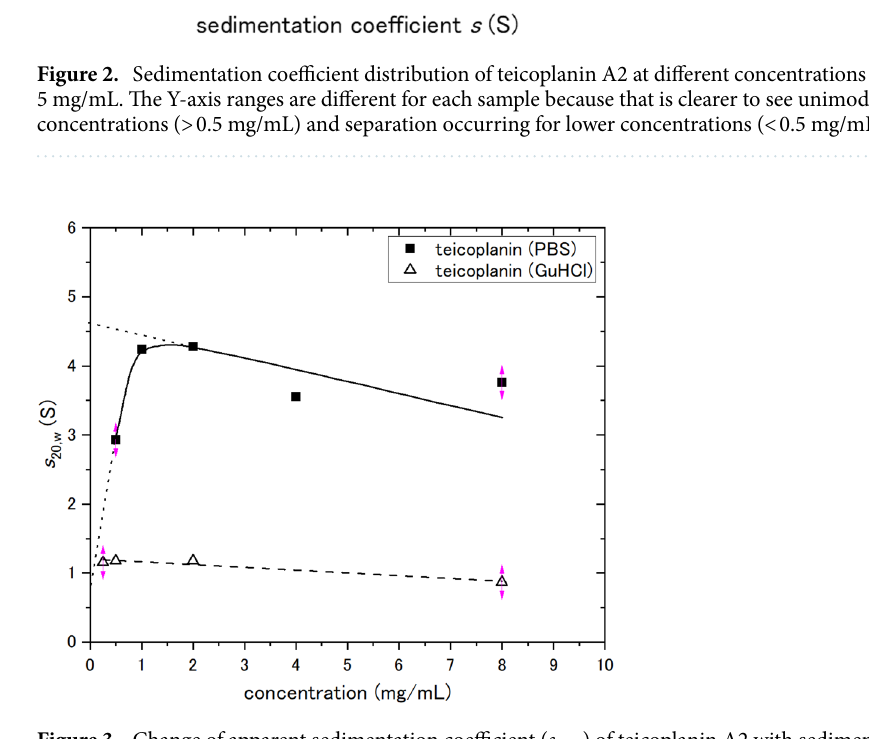
Figure 3. Change of apparent sedimentation coefficient ( s 20,w ) of teicoplanin A2 with sedimenting concentration, c . Concentrations were corrected for radial dilution. The extrapolated value of ~ 4.65 S is consistent with a spherical 18–19-mer of molar mass of 35,400 g/mol. The lower extrapolated value of ~ 0.7 S is the predicted value for a spheroidal unimer, which is consistent with the s -value of teicoplanin dissolved in 6 M GuHCl, s 20,w = (1.17 ± 0.01) S. Solid line is a standard French curve fit to the